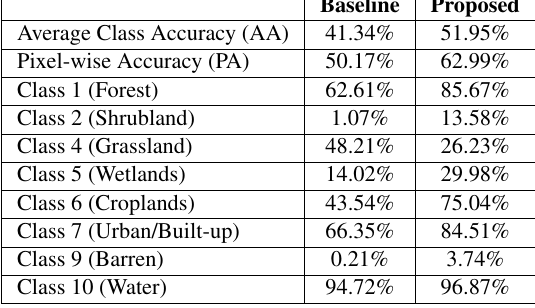
Table 3: Performances on DFC2020 Validation set.